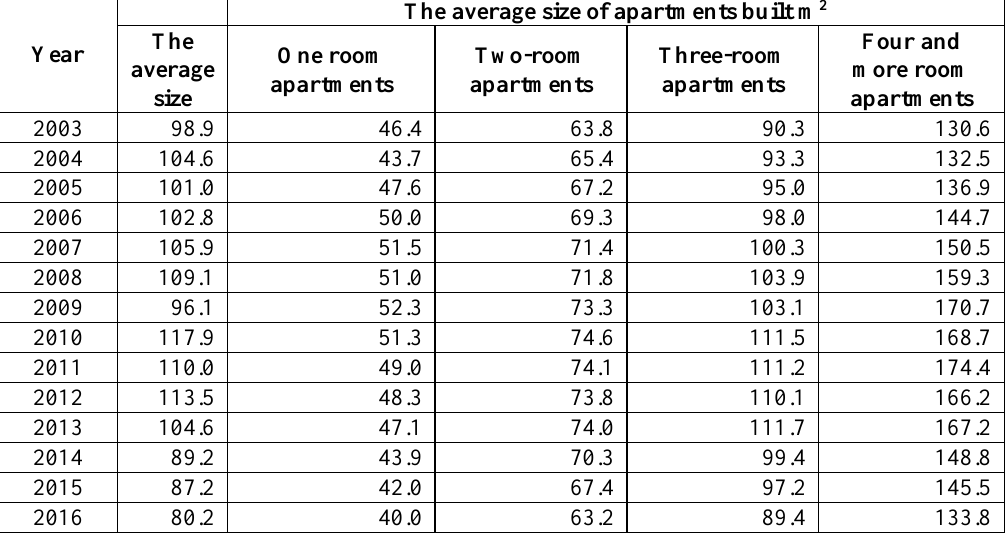
Table 3 . The average size of apartments built, m